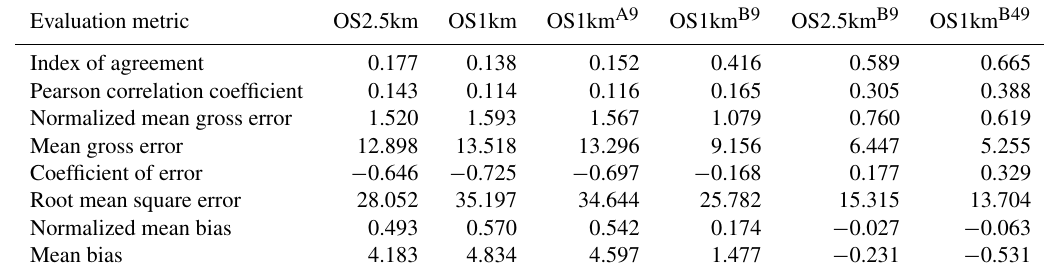
Table 3. Surface NO x observations to model comparison for entire simulation period (ppbv, 3257 model–observation pairs). Evaluation